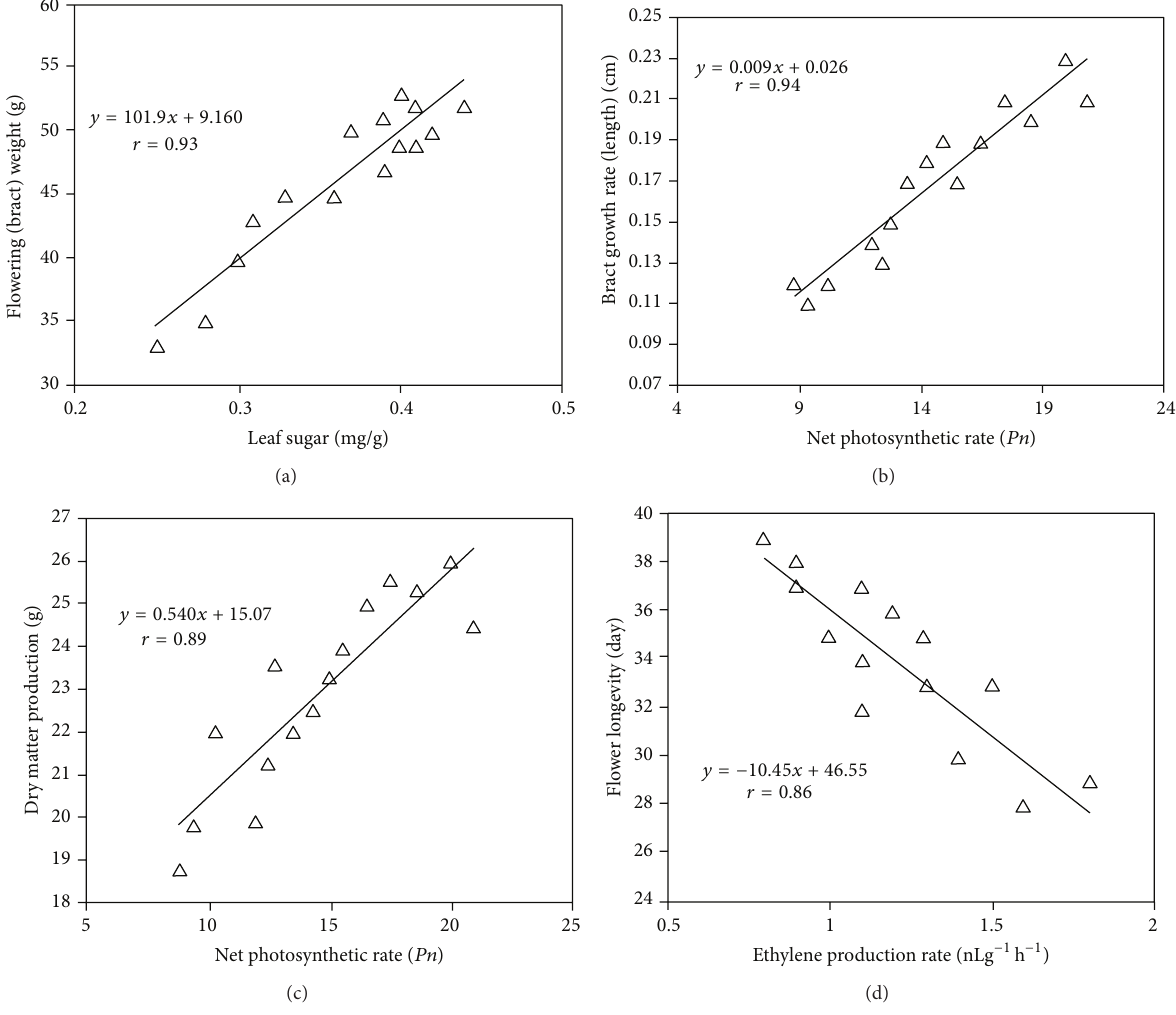
Figure 8: Regression lines for the correlations between flower weight (bract) and leaf sugar content (a), between net photosynthetic rate and bract growth rate (b), between net photosynthetic rate and dry matter production (c), and between flower longevity and the ethylene production rate (d) in TRIA-treated Bougainvillea plants under natural